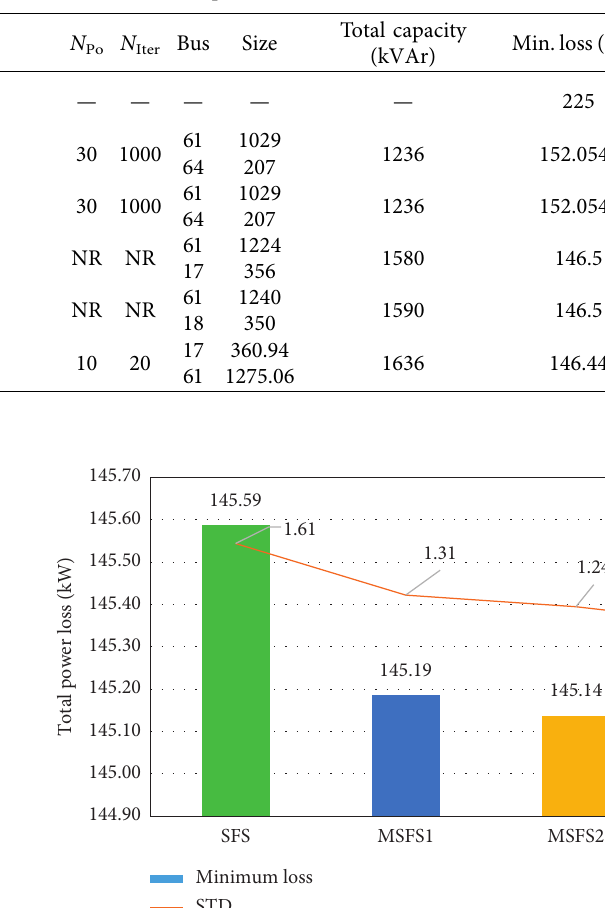
Figure 13: Total power loss of 50 trial runs obtained by SFS methods for case 1 of the 69-bus system. Table 5: Comparison with other methods for case 1 of the 69-bus distribution system.